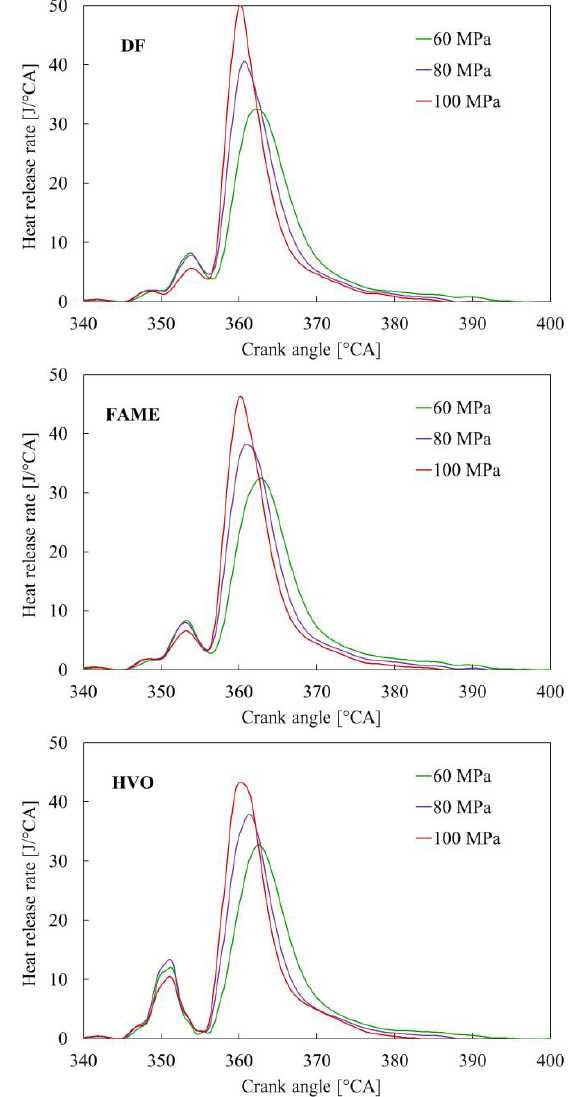
Fig. 3. HRRs for investigated rail pressures and for DF, FAME and